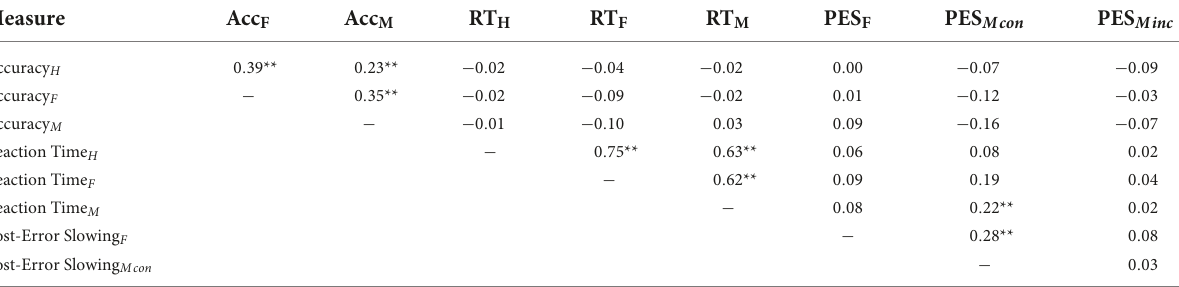
TABLE 3 Zero-order correlations between accuracy, reaction times (RT), and post-error slowing (PES) for the Heart (H), Flower (F), and the Mixed (M) blocks.